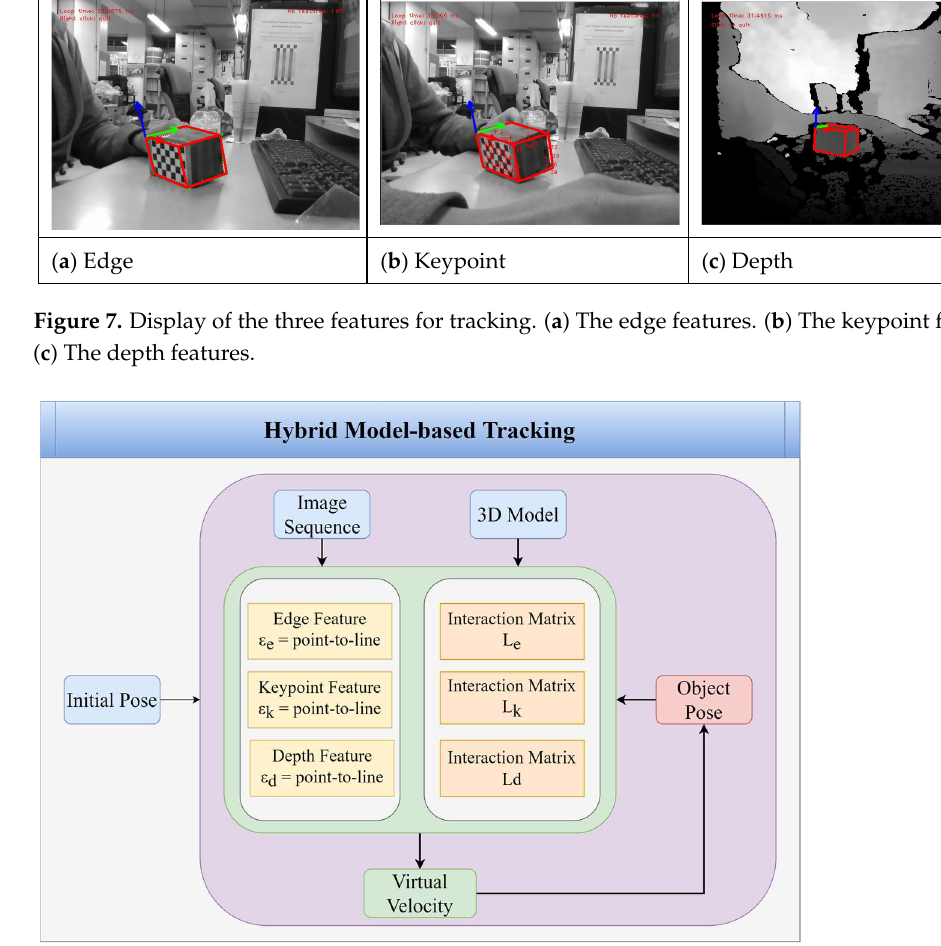
Figure 8. The architecture of the hybrid model-based tracking.